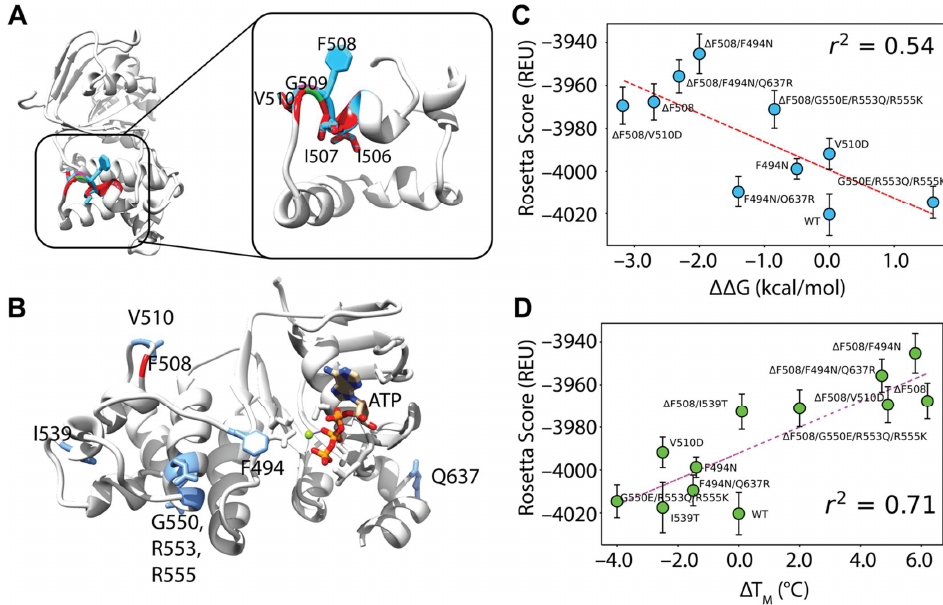
Figure 3. Comparative modeling of F508del NBD1 using five templates correlates well with experimental data. ( A ) An overlay of WT and F508del CFTR NBD1 structures at the H3/H4 loop. WT is depicted in blue and F508del is depicted in red with just the α-helical subdomain shown for clarity. Deletion of F508 leaves surrounding residues I506, I507 and V510 relatively unaltered. ( B ) The model for testing included NBD1 bound to ATP. Residues mutated in second site suppressor mutations are shown in blue including F494N, V510, I539, G550, R553, R555, and Q637. ( C ) Testing correlation between Rosetta score given in REU and ΔΔG values from the literature (Table S1, Supplementary Materials). Error bars represent standard error of the mean. Error in experimental data likely lies lower than ±1–2 kcal/mol. R squared represents Pearson correlation coefficient. ( D ) Testing correlation between Rosetta score given in REU and ΔTM values from the literature (Table S2, Supplementary Materials). Error bars represent standard error of the mean. Error in experimental data likely ranges with ±1–2 C. R squared represents Pearson correlation coefficient.